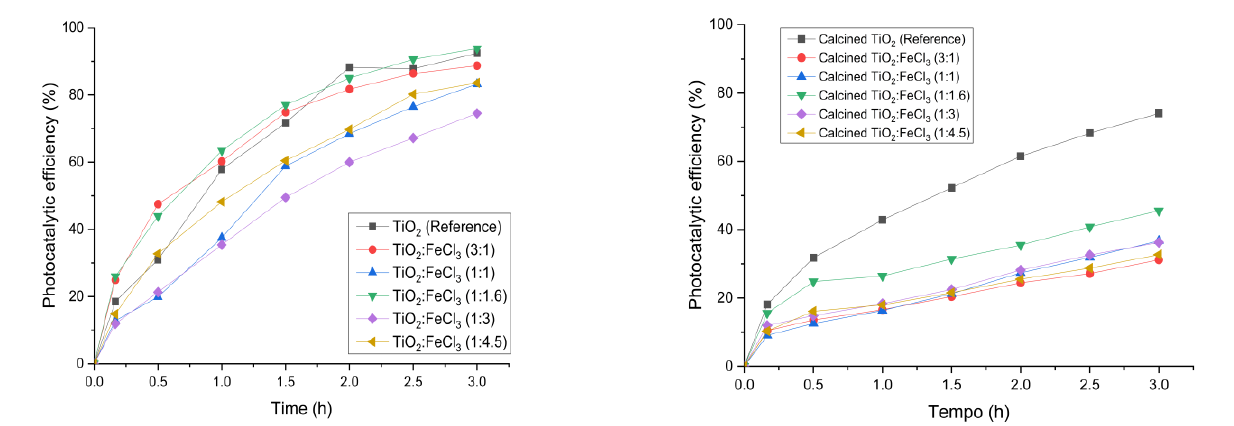
Figure 6. Photocatalytic efficiency for TiO 2 (reference), calcined TiO 2, and the synthesized samples before calcination ( left ) and after calcination ( right ).